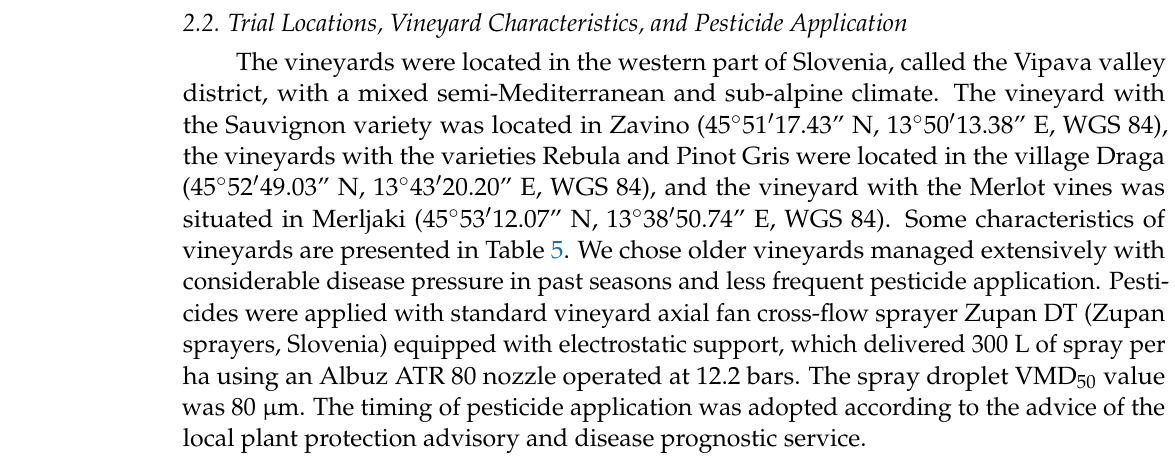
Table 5. Characteristics of vineyards where the trials were